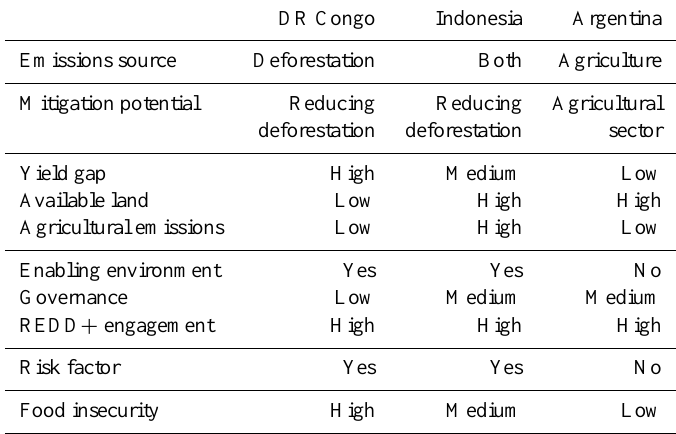
Table 5. Mitigation potential for DR Congo, Indonesia and Argentina. DR Congo Indonesia Argentina Emissions source Deforestation Both Agriculture Mitigation potential Reducing Reducing Agricultural deforestation deforestation sector Yield gap High Medium Low Available land Low High High Agricultural emissions Low High Low Enabling environment Yes Yes No Governance Low Medium Medium REDD + engagement High High High Risk factor Yes Yes No Food insecurity High Medium